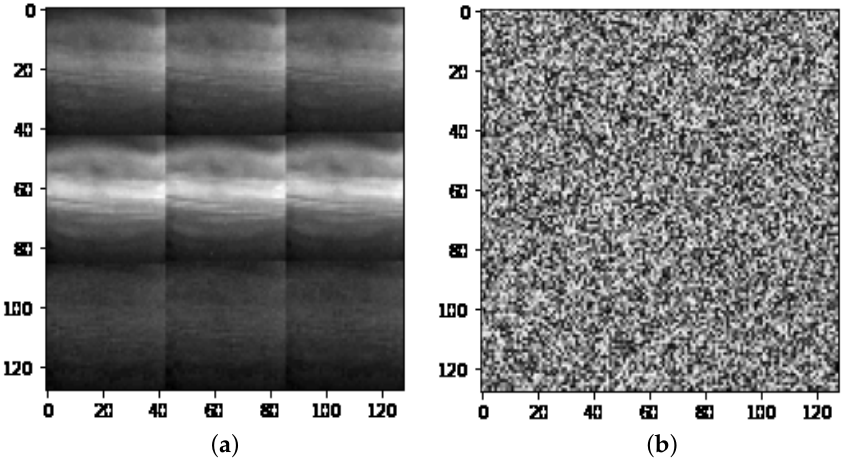
Figure 5. ( a ) The aurora label-6 (faint clear). ( b ) A noisy